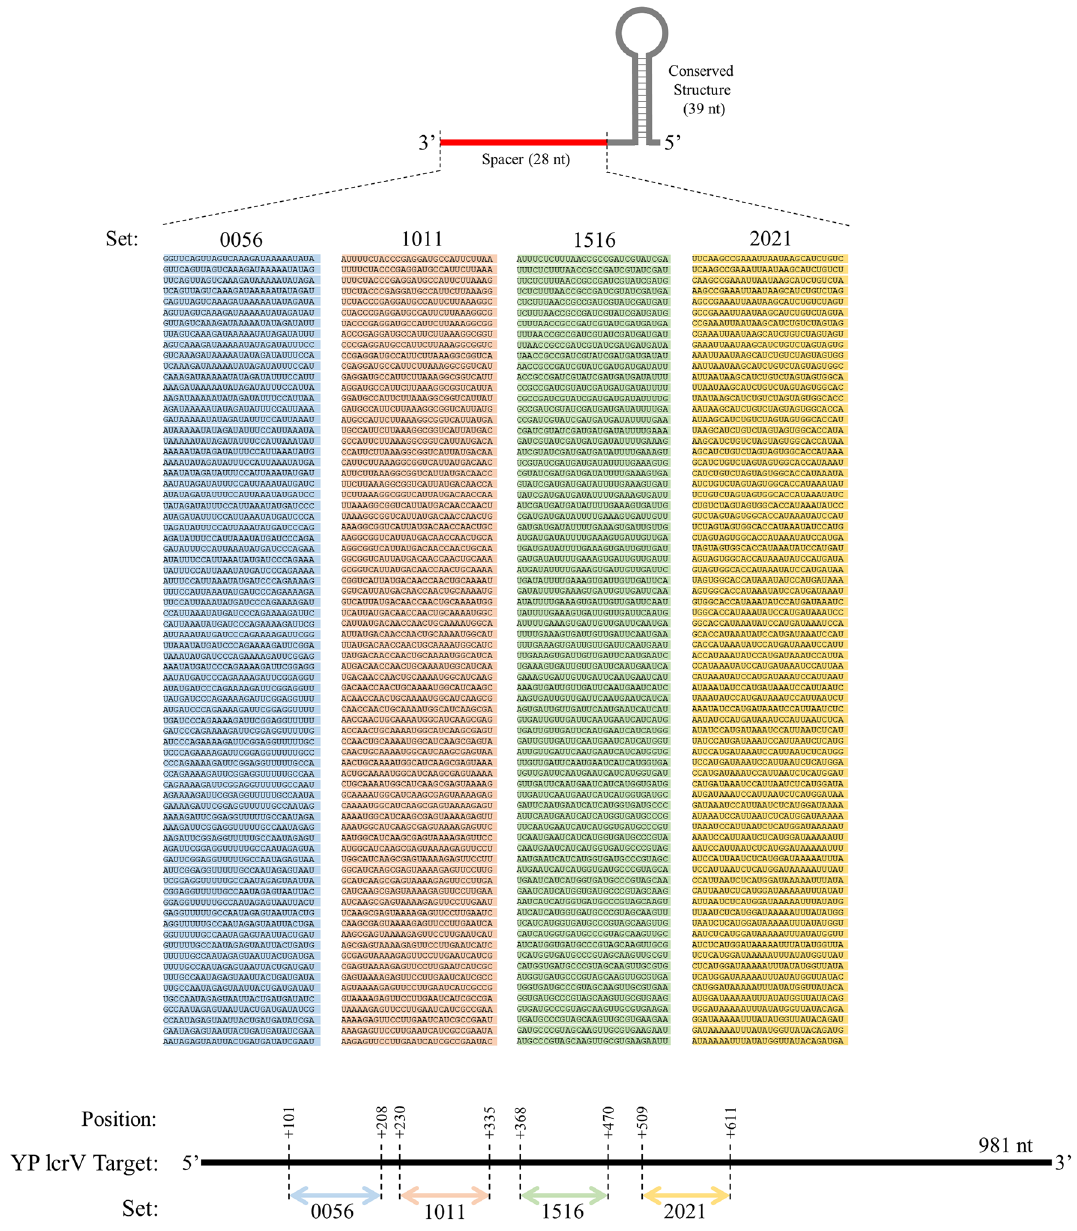
Figure 1. Schematic and sequences of spacer regions for crRNA guide design targeting areas of the lcrV